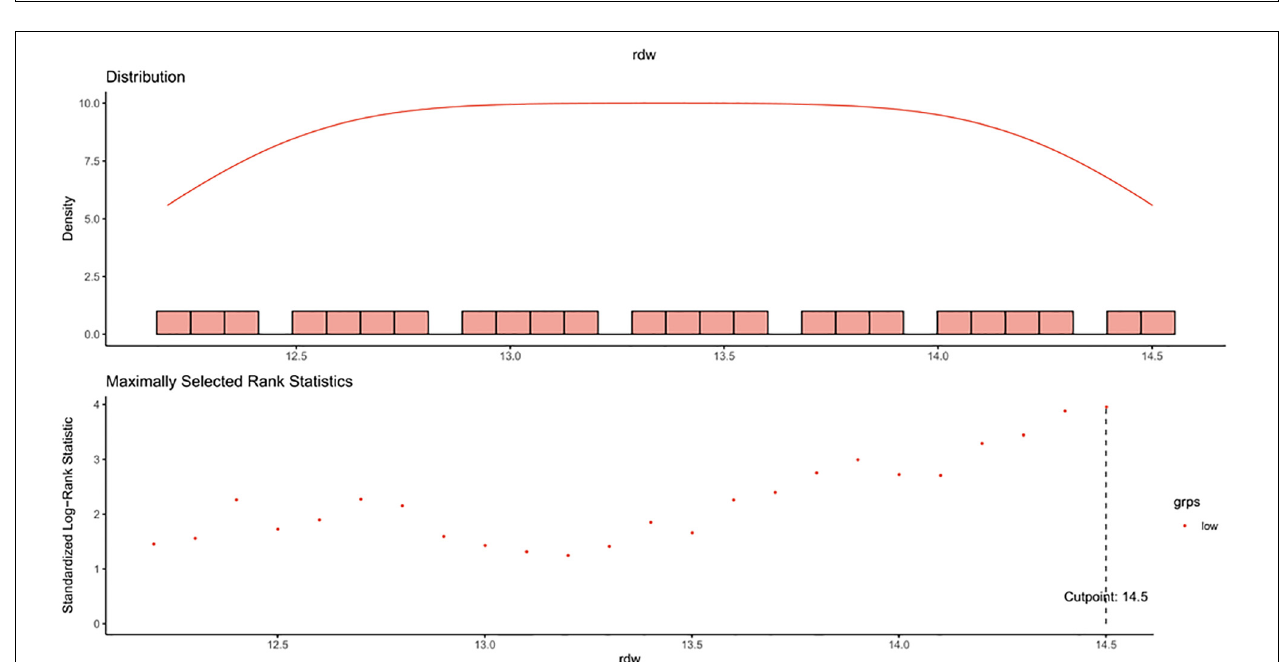
FIGURE 1 | Flow chart of study population. eGFR, estimated glomerular filtration rate; RDW, red blood cell distribution width.